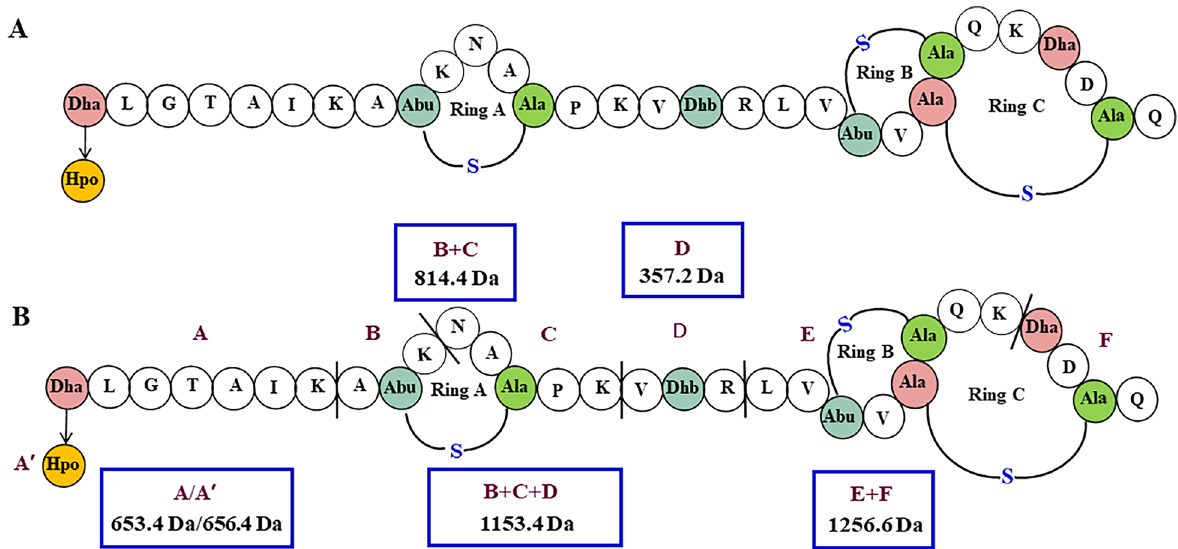
Figure 3. Proposed structure of Homicorcin. (A) Posttranslationally modified residues are indicated as follows: Dha,- dehydroalanine; Dhb—dehydrobutyrine; Abu—aminobutyric acid; Abu-S-Ala -Methyllanthionine; Dha- S-Ala – Lanthionine. The first residue Dha to be modified to 2-hydroxypropionate (Hpo) in homicorcin 1 is shown in a yellow circle. ( B ) Trypsin digestion sites of homicorcin and identified fragments by LC–MS (Trypsin digestion sites are indicated by (|) and digested fragments of the peptide are marked as A – F ). The digested fragments obtained by trypsin digestion are (blue colored box) A- 653.4 Da, B + C- 814.4 Da, D- 357.2